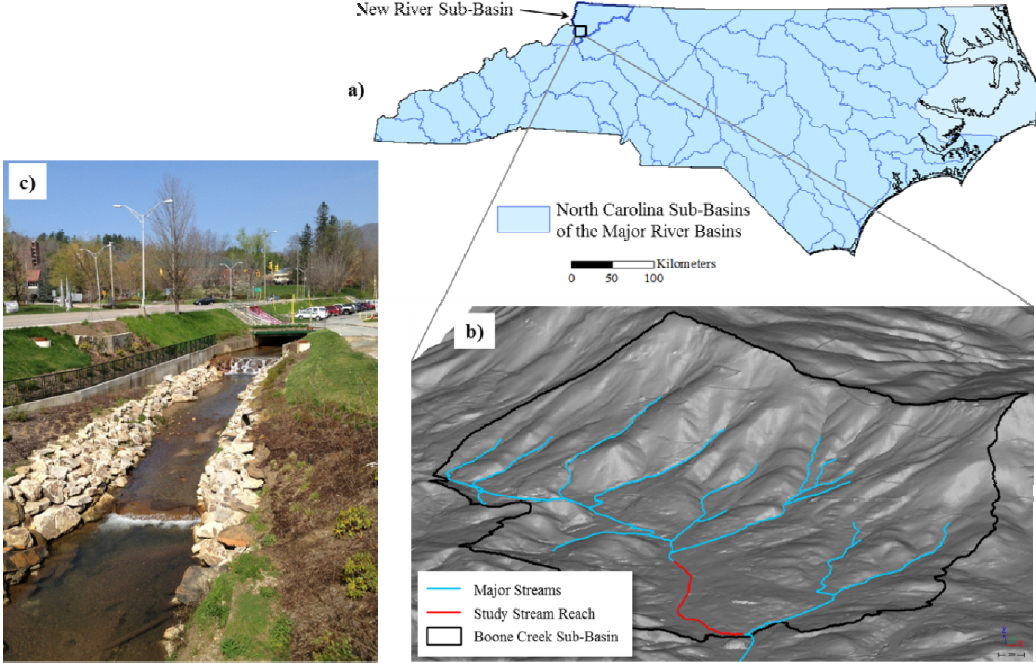
Figure 1. Study area: ( a ) Location of the Upper South Fork of the New River (USFNR) watershed in North Carolina. Source: [44]; ( b ) Hillshade-relief image of the Boone Creek sub-basin located in the USFNR watershed derived from bare-earth airborne LiDAR data. The major streams are indicated in blue while the location of the study stream reach is highlighted in red; ( c ) Photograph looking upstream on Boone Creek at the open channel and the end of the culvert through which part of the study stream reach